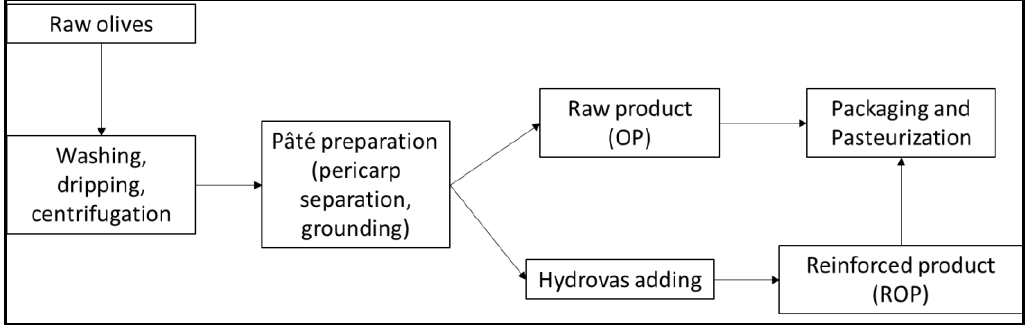
Figure 1. Reinforced olive pâté production process.